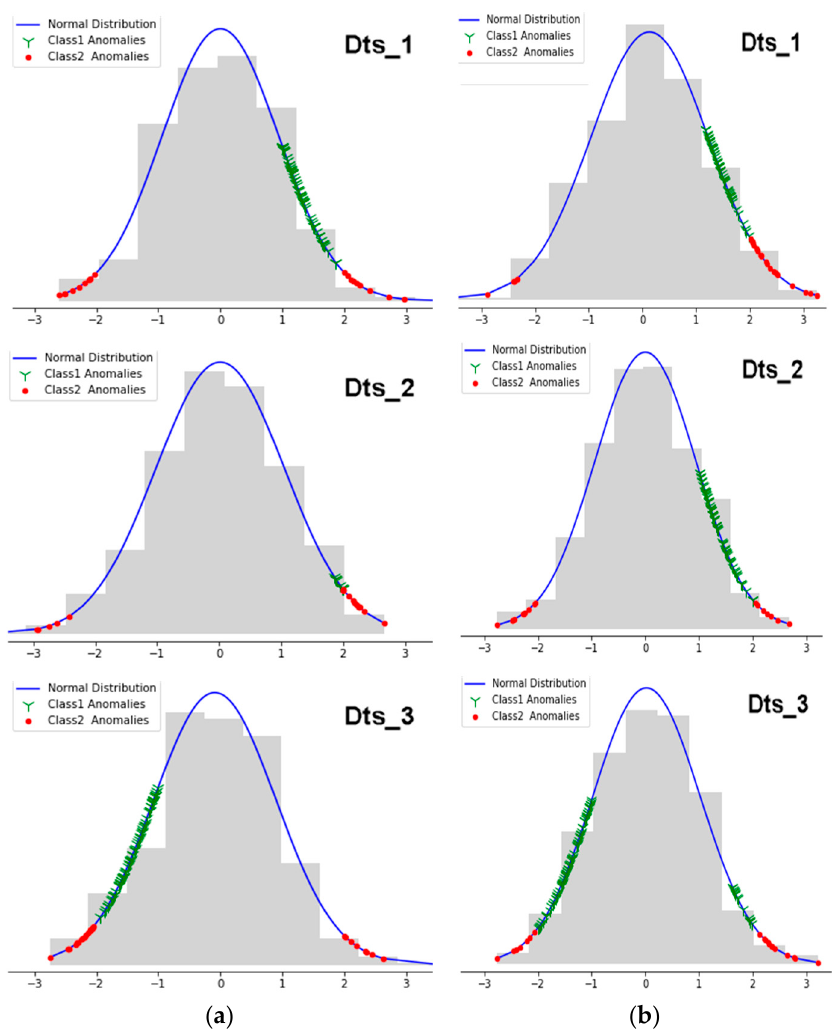
Figure 14. ( a ) Anomaly classes 1 and 2 of the normalized Sys measures and ( b ) anomaly classes 1 and 2 of the normalized Dias measures.